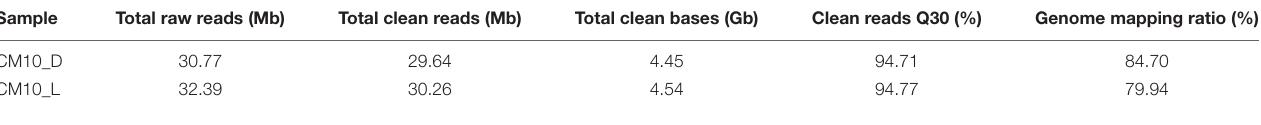
TABLE 1 | Summary of transcriptome sequencing.